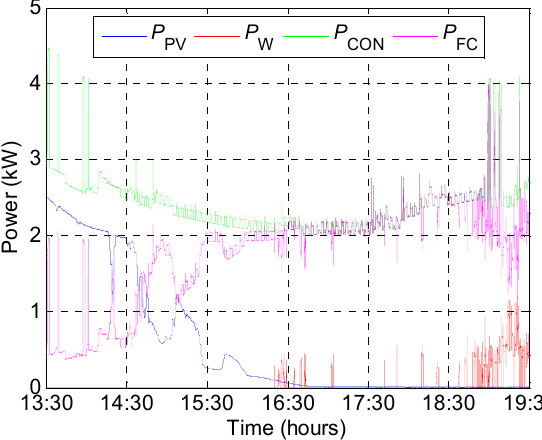
), wind power ( P PV ) measured in the microgrid on the 9th December FC